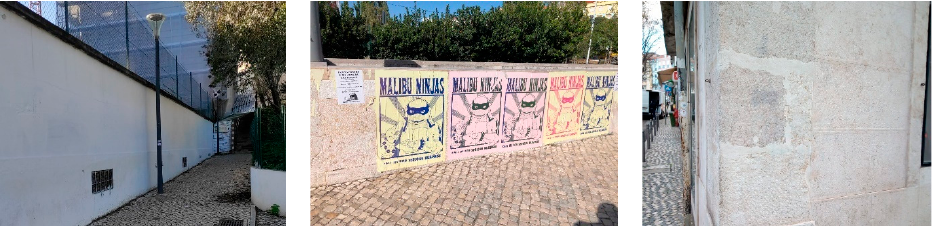
Figure 8. Dataset samples of images without graffiti.